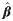
Standard RSA introduces bias structure to the similarity matrix.(A) A cognitive task including 16 different experimental conditions. Transitions between conditions follow a Markov process. Arrows indicate possible transitions, each with p = 0.5. The task conditions can be grouped into 3 categories (color coded) according to their characteristic transition structure. (B) Standard RSA of activity patterns corresponding to each condition estimated from a brain region reveals a highly structured similarity matrix (left) that reflects aspects of the transition structure in the task. Converting the similarity matrix C to a distance matrix 1-C and projecting it to a low-dimensional space using MDS reveals a highly regular structure (right). Seeing such a result, one may infer that representational structure in the ROI strongly reflects the task structure. (C) However, applying RSA to regression estimates of of patterns obtained from pure white noise generates a very close similarity matrix (left), with a similar low-dimensional projection (right). This indicates that standard RSA can introduce spurious structure in the similarity matrix that does not exist in the data. (D) RSA Using Euclidean distance as a similarity metric applied to patterns estimated from the same noise (left) yields a slightly different, but still structured, similarity structure (right). (E) Calculating the correlation between raw patterns of resting state fMRI data (instead of patterns estimated by a GLM), assuming the same task structure as in (A), also generates spurious similarity structure, albeit different from those in (B-D). This structure is significantly correlated with the theoretical bias structure (details in main text). Left: average of the similarity structure based on raw patterns. Right: average of the theoretical bias similarity structure arising purely from task structure and fMRI noise autocorrelation. (F) The bias in this case comes from structured noise introduced during the GLM analysis. Assuming the true patterns β (red dots) of two task conditions are anti-correlated (the horizontal and vertical coordinates of each dot represent the response amplitudes of one voxel to the two task conditions), regression turns the noise ϵ in fMRI data into structured noise (XT
X)−1
XTϵ (blue dots). The correlation between the noises in the estimated patterns is often non-zero (assumed to be positive correlation here) due to the correlation structure in the design matrix and the autocorrelation property of the noise. The estimated patterns β^ (purple dots) are the sum of β and (XT
X)−1
XTϵ. The correlation structure between estimated activity vectors for each condition will therefore differ from the correlation structure between the true patterns β. (G) Distribution of the autocorrelation coefficients in a resting state fMRI dataset, estimated by fitting AR(1) model to the time series of each voxel resampled at TR = 2.4s. The wide range of degree of autocorrelation across voxels makes it difficulty to calculate a simple analytic form of the bias structure introduced by the structured noise, and calls for modeling the noise structure of each voxel separately.